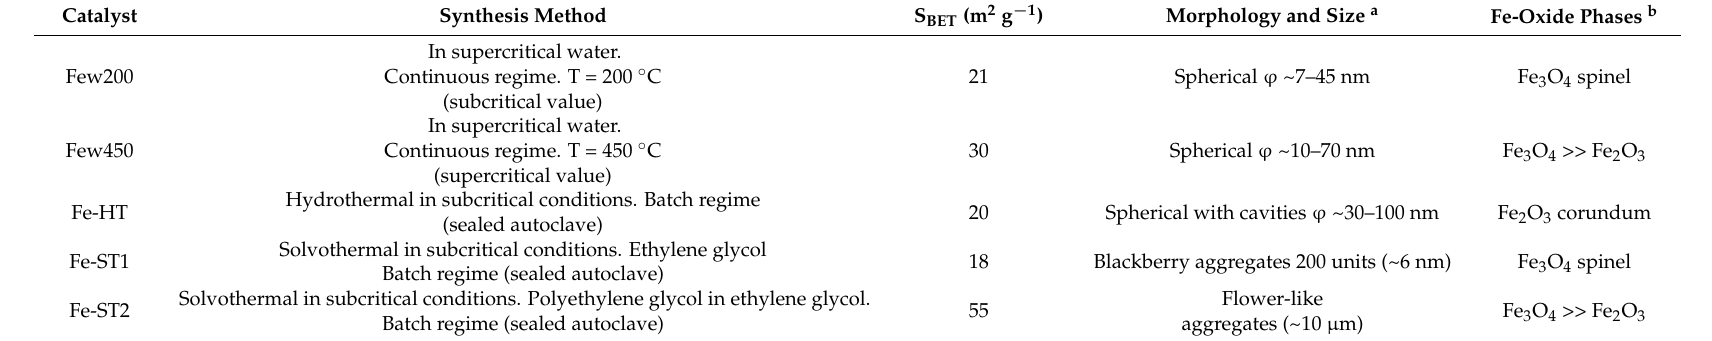
Table 1. Summary of notation, preparation and some physicochemical properties of the FeOx